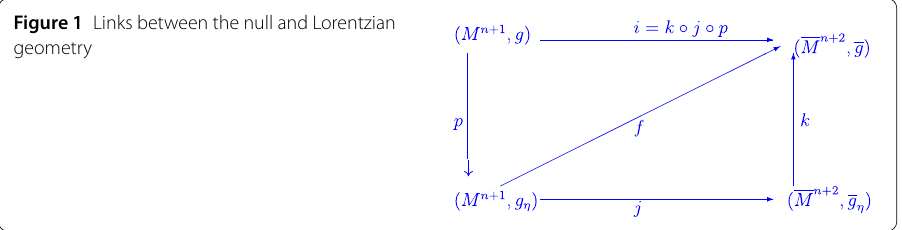
Figure 1 Links between the null and Lorentzian